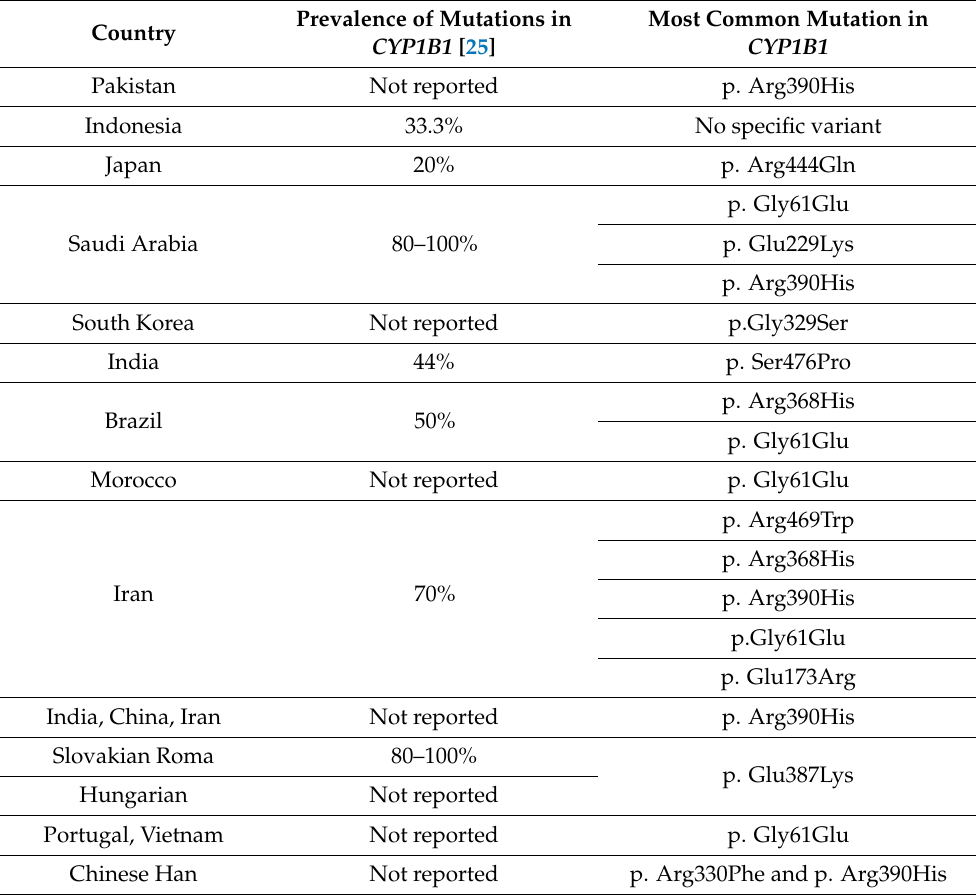
Table 1. Common mutation/s for CYP1B1 pathogenic variants with their respective country or ethnicity. Prevalence of mutations in CYP1B1 as reported in [25]. The most common mutations reported in the studies reviewed. Over 140 alterations including deletions, insertions and missense mutations identified in CYP1B1 [36]. Prevalence of Mutations in Country CYP1B1 [25]